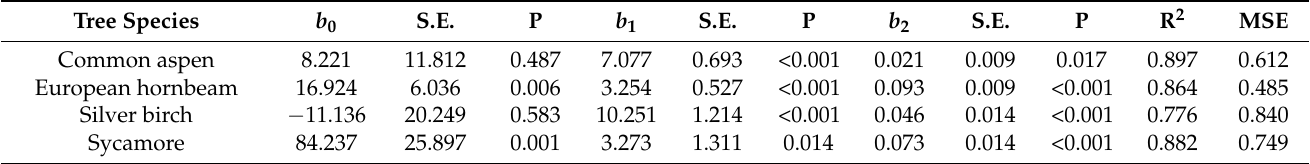
Table 1. Basic statistical characteristics of relationships between diameter at stem base and tree height derived for four broadleaved species using equation in Figure 1d. Here, b 0 , b 1 and b 2 are regression coefficients; S.E. is standard error; P is p -value; R 2 is coefficient of determination and MSE is mean square error.